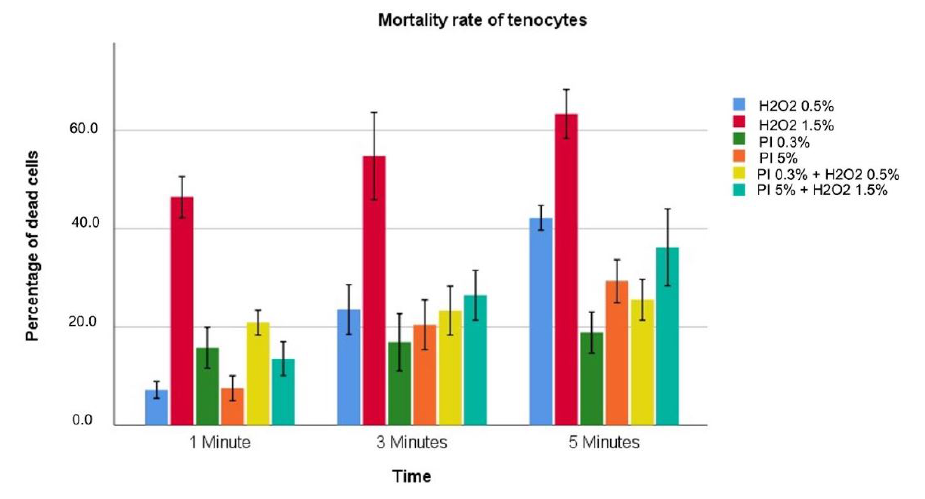
Figure 2. Different colors indicate different solutions. The height indicates the percentage of dead cells for the highlighted solution at that specific exposure time associated with 95%CI.